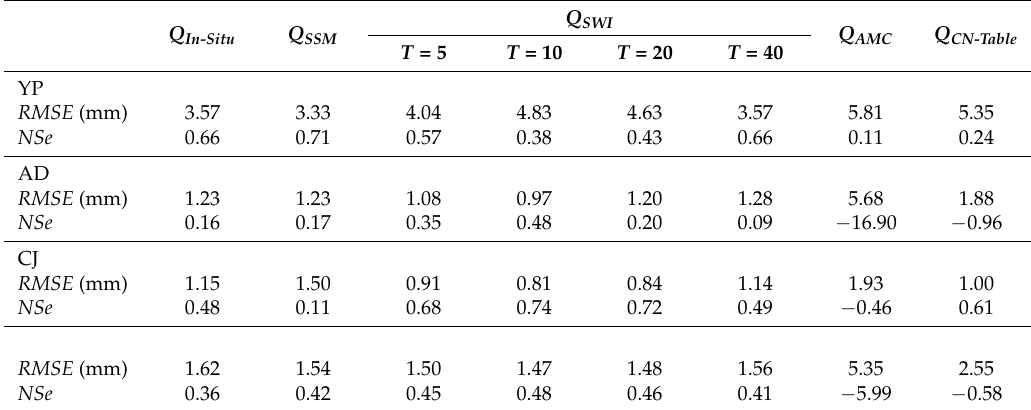
Table 7. Comparative coefficient results of estimated runoff depth using CN–P relationship ( Q CNP ), modified antecedent moisture condition ( Q AMC ), remotely sensed surface soil moisture through ASCAT ( Q SSM ), and ASCAT soil water index ( Q SWI ). Q SWI Q In-Situ Q SSM Q AMC Q CN-Table T =